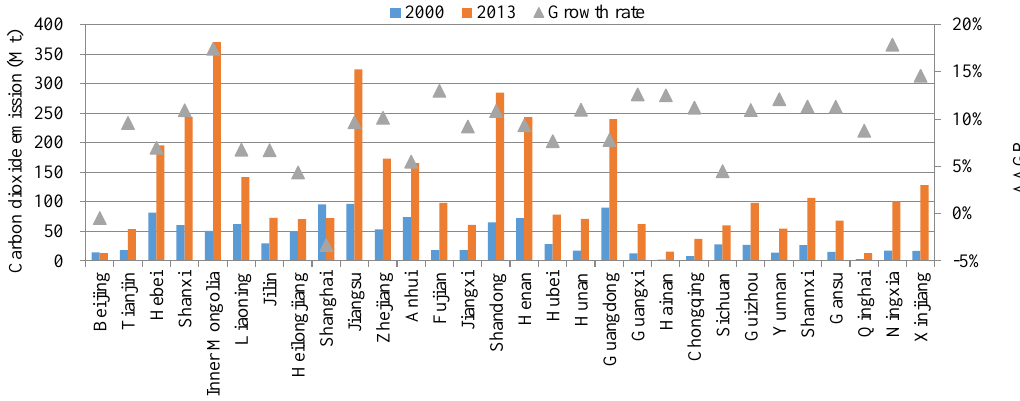
Figure 3. Carbon dioxide emission and related indicators for the whole 30 provinces, 2000–2013.